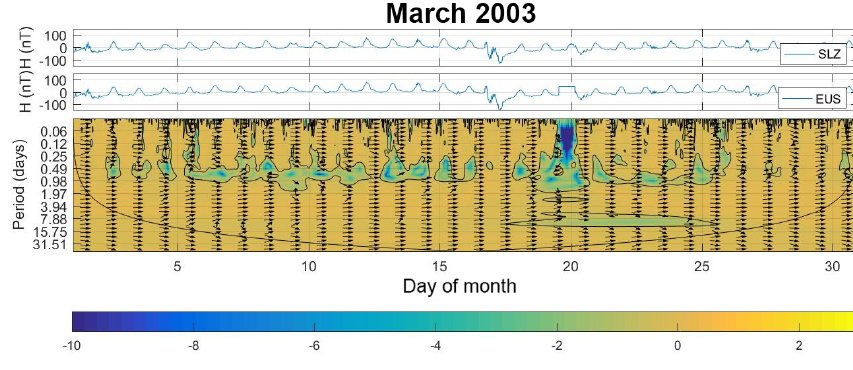
Figure 6. The same as Fig. 4 but for SLZ and EUS.